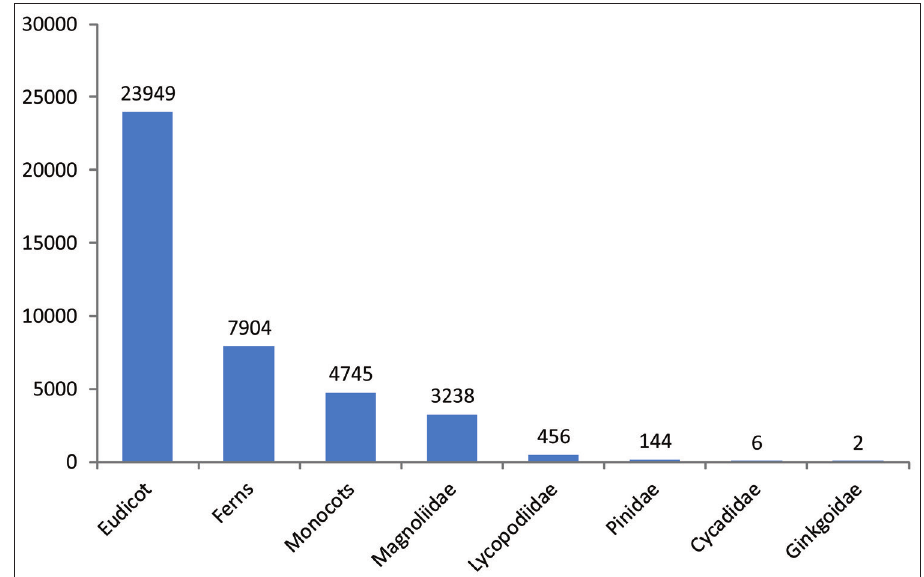
Figure 1. Number of specimens distributed among the division of vascular